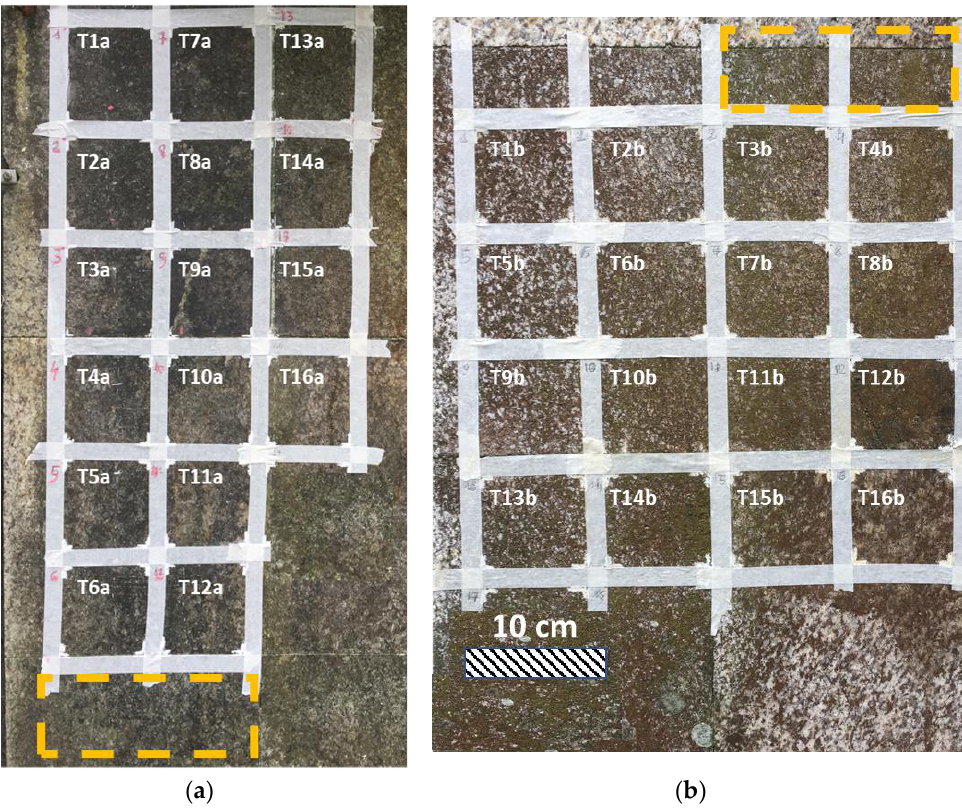
Figure 2. ( a ) Surface a; ( b ) Surface b. Composition of each treatment: T1 = O. vulgare ; T2 = T. vulgaris ; T3 = C. nepeta ; T4 = Carvacrol; T5 = Thymol; T6 = Pulegone; T7 = O. vulgare + T. vulgaris ; T8 = O. vulgare + C. nepeta ; T9 = C. nepeta + T. vulgaris ; T10 = O. vulgare + T. vulgaris + C. nepeta ; T11 = Carvacrol + Thymol; T12 = Carvacrol + Pulegone; T13 = Pulegone + Thymol; T14 = Carvacrol + Thymol + Pulegone; T15 = Hydrogel; T16 = Brushing. The orange rectangles individuate the zones where the biological material was collected.